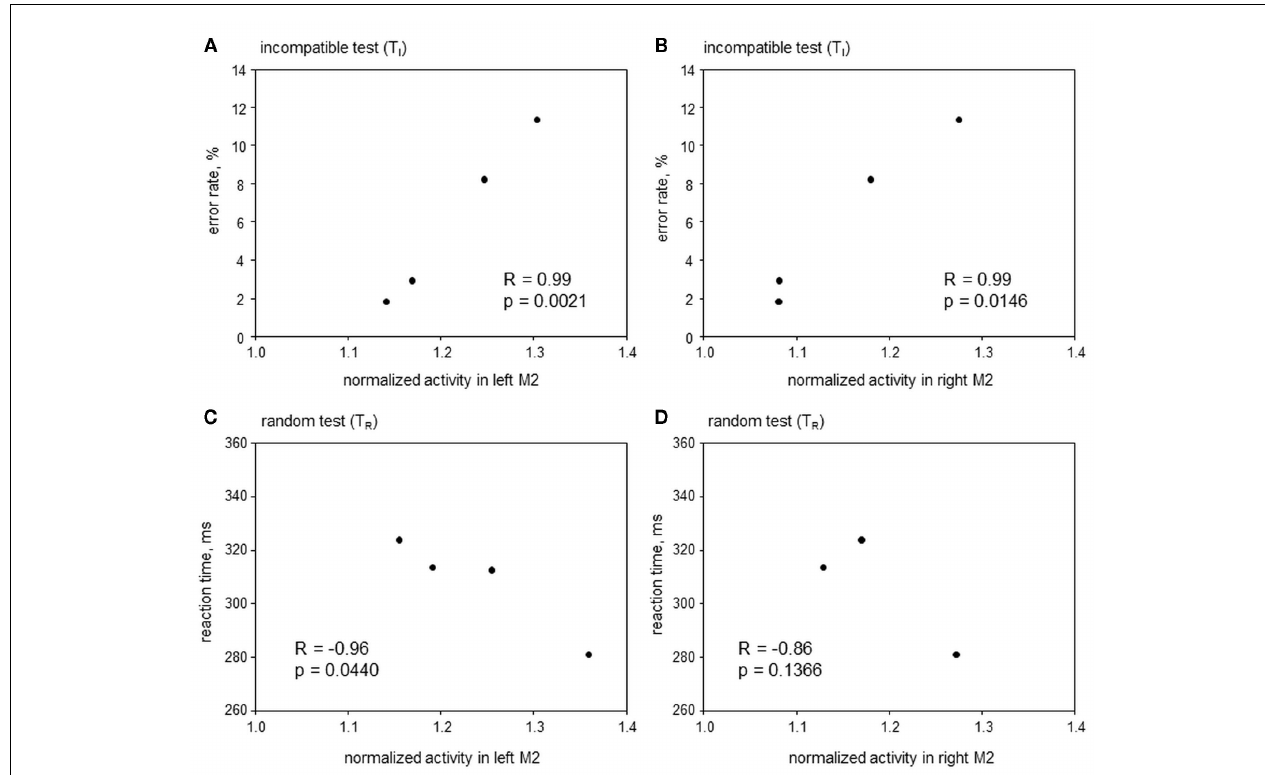
FIGURE 7 | Correlative approach: error rates and reaction times in Simon tasks containing incompatible trials ( T I and T R ), plotted over metabolic